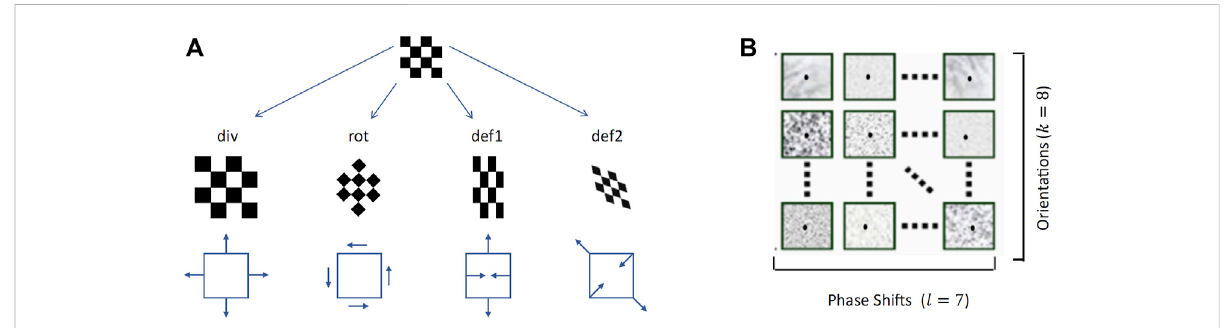
FIGURE 7 (A) The differential elementary components of a vector fi eld, namely divergence, rotation and two components of deformations (Koenderink and van Doorn, 1979) (B) Examples of the bio-inspired activation maps of the population of complex binocular neurons (57 maps), for each single slant and tilt rotation pair and each single gaze direction.